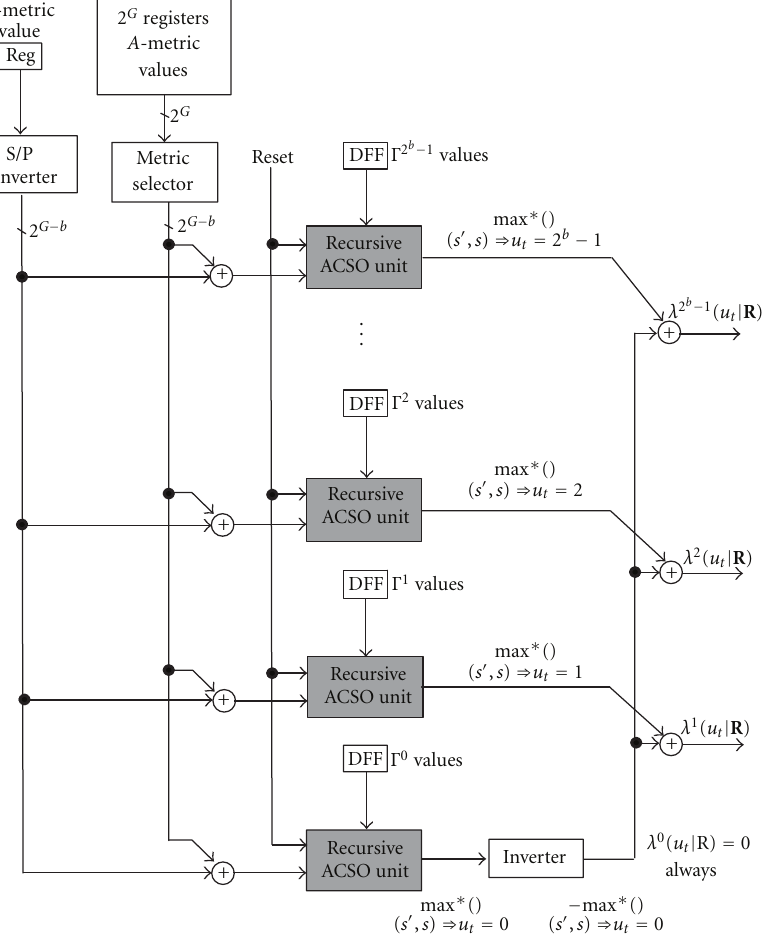
Figure 6: Log-likelihood ratio calculation module.